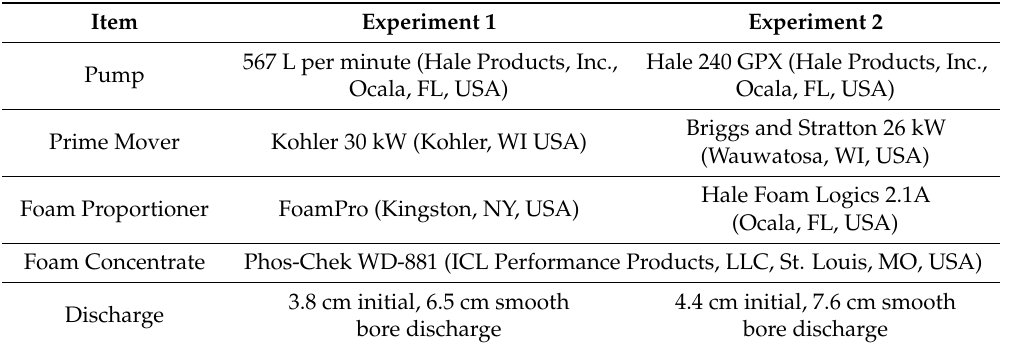
Table 1. Summary of the compressed air foam systems (CAFS) for Experiments 1 and